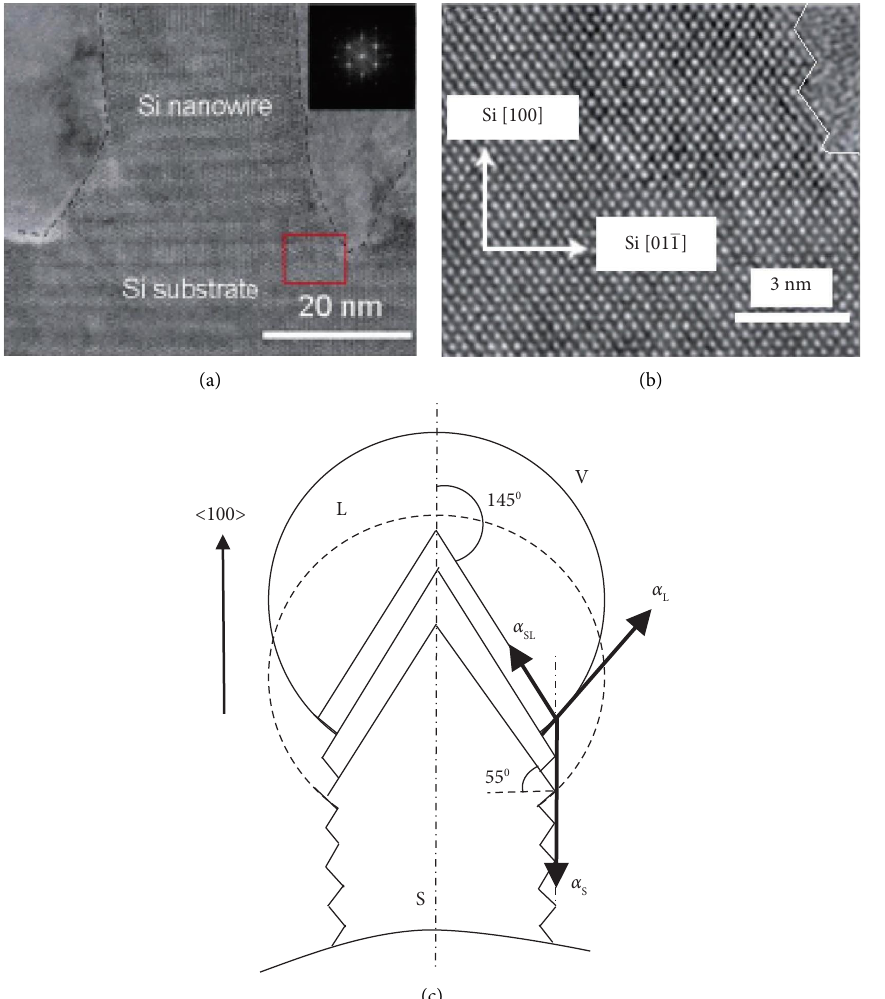
Figure 7: TFN image of Si NWs, grown in < 100 > direction on Si substrate (100) ( a ), enlarged image of a section of this crystal (b) [24], and scheme growing in the < 100 > direction (c).